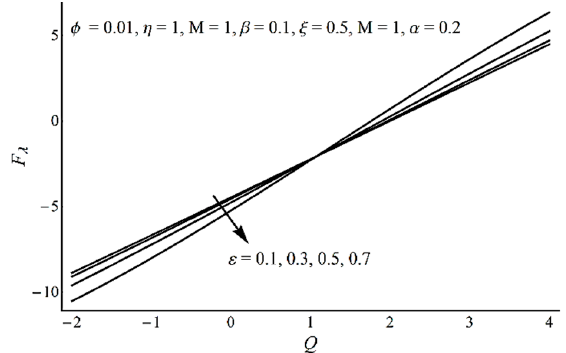
Figure 28. Variations in frictional forces for different values of ε .